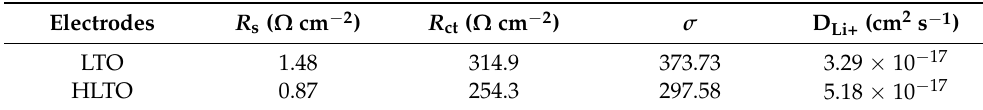
Table 1. Summary of the EIS fitting results of LTO and HLTO.